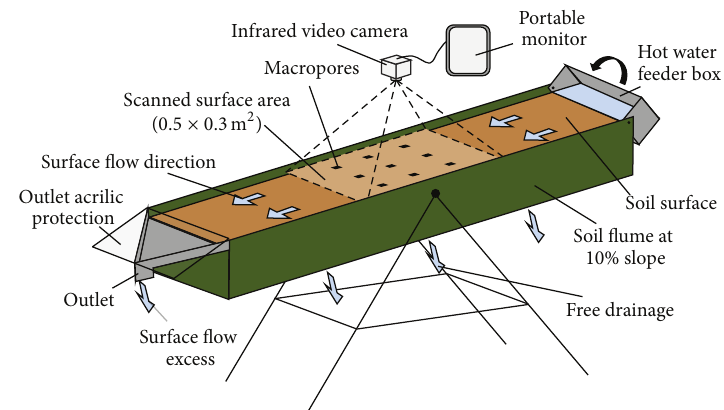
Figure 1: Sketch of the laboratory setup using a soil flume and an infrared video camera.